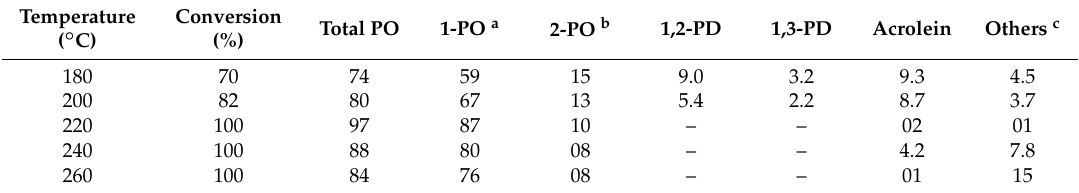
Table 17. Effect of reaction temperature on glycerol hydrogenolysis over 2Pt/TiP catalyst.